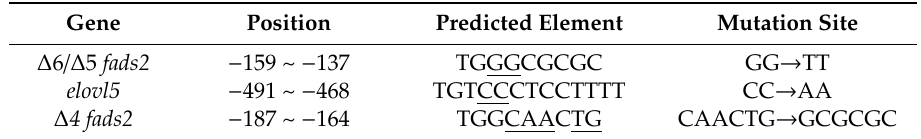
Figure 6. Effects of Sp1 site-directed mutations on the promoter activity of S. canaliculatus Δ 6/ Δ 5 fads 2 ( a ) and elovl5 ( b ) detected in HepG2 cells. The negative control pGL4.10 is an empty vector with no promoter sequence upstream the reporter gene. The y-axis is the Firefly/Renilla luciferase ratio, while the x-axis stands for different reporter vector. Data were mean ± SEM from six independent experiments and asterisks represent significant differences ( p < 0.05). Table 1. Sp1 binding sites predicted in the promoter of rabbitfish S. canaliculatus ∆ 6 / ∆ 5 fads2 and elovl5 using online software and site-directed mutation sites.